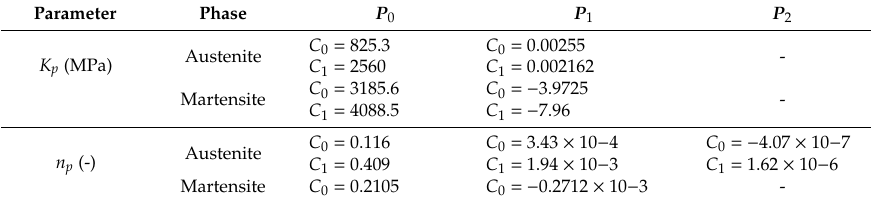
Table 2. Hardening parameters for steel SAE 5120 according to work in [21,22].